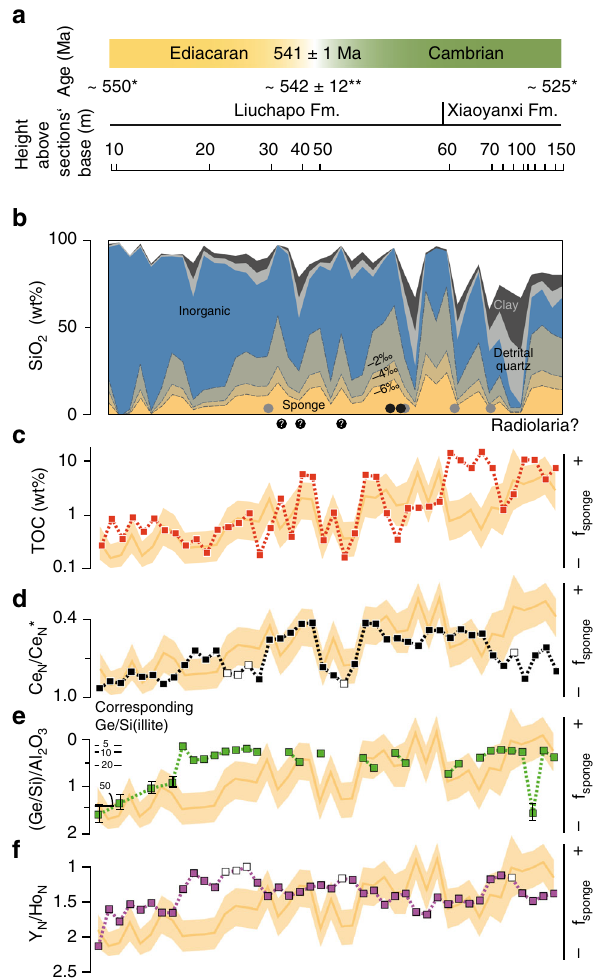
Fig. 2 The estimated siliceous sponge spicule abundance and geochemical records across the Ediacaran – Cambrian boundary at the Lijiatuo section. a Stratigraphic context and age of the Lijiatuo section based on stratigraphic records from South China 25 (*) and a dated ash layer 26 (**); b Abundance of Si-bearing components calculated by a geochemical mass balance. Colour shading at the bottom indicates several estimates for the abundance of sponge-derived- and inorganic silica based on assumptions of ε 30 Si (sponge-seawater) between − 6 ‰ and − 2 ‰ . Occurrences of sponge spicules and putative radiolarians, i.e., round objects (Supplementary Fig. 5) are indicated by black circles (our samples) and gray circles 28 . c TOC concentrations; d Ce N /Ce N * (Ce-anomalies); open symbols mark samples with Pr N /Yb N > 1, indicating fl at, non-seawater REE patterns; e Al 2 O 3 -normalized Ge/Si and corresponding Ge/Si of illite; f Y N /Ho N ratios. For better visibility, samples are plotted with an equidistant X axis. In c - f f sponge ( yellow shades ) shows the abundance of Si in sponges relative to total non-detrital Si-bearing components that is independent of ε 30 Si (sponge-seawater) . Uncertainty envelopes of f sponge are calculated from uncertainties in endmember estimates and a Monte Carlo procedure, and represent 50% con fi dence intervals (Supplementary Data